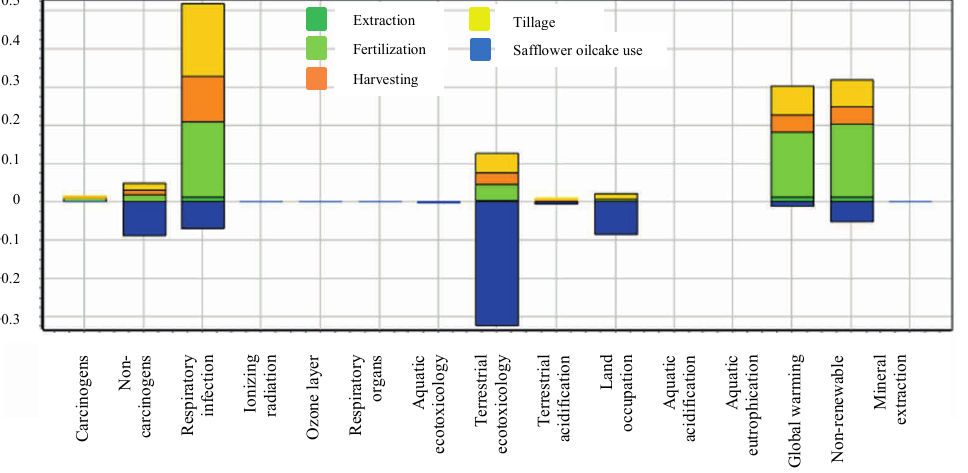
Fig. 2. Environmental impact of the various components of the production cycle of safflower oil referring to one ton of oil produced; normalization phase, mid-point categories. Figs. 2 and 3 also show the results of cake employment in the feed production,